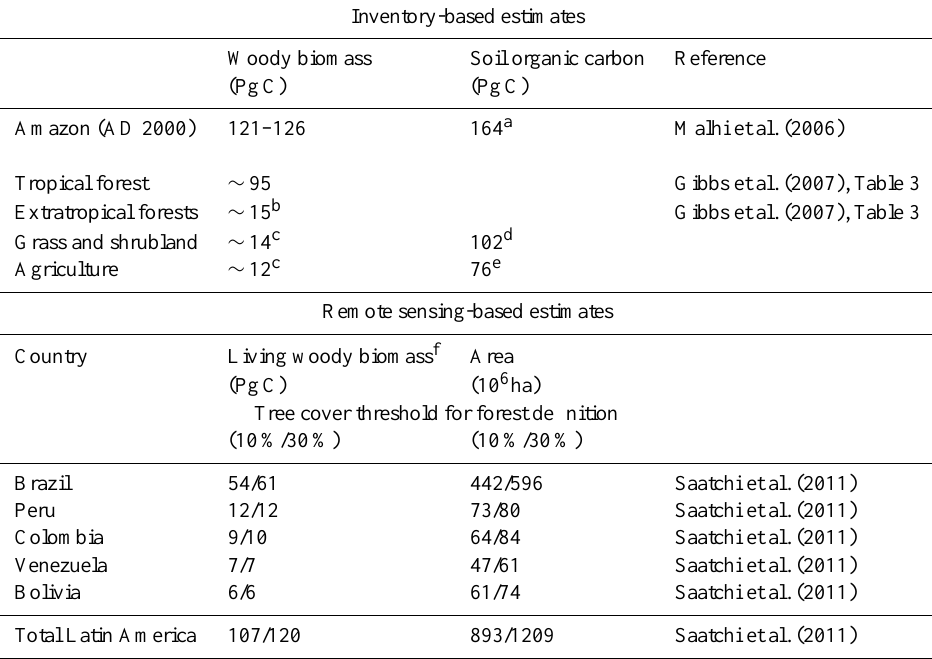
Table 1. Carbon stocks.